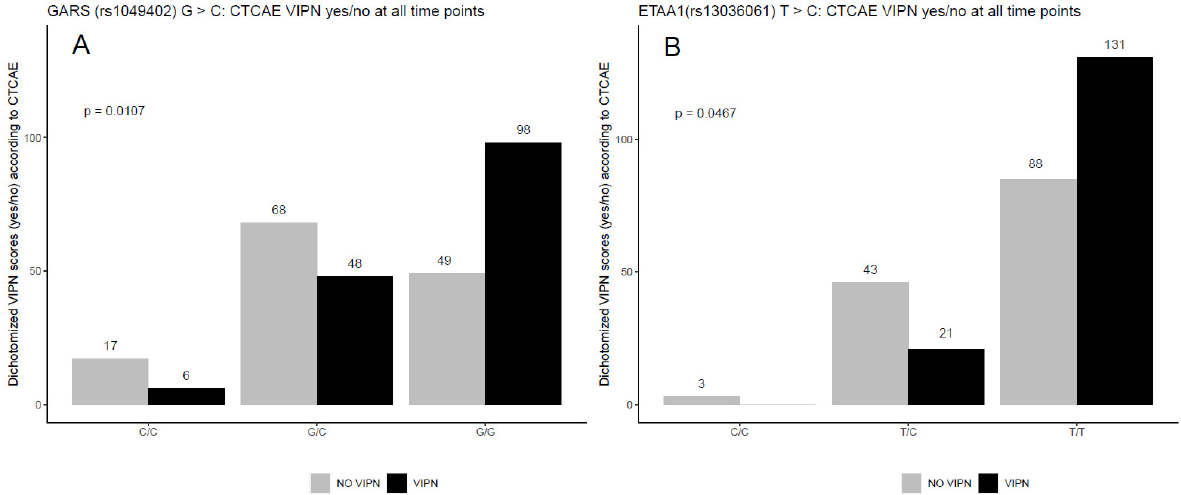
Figure 2. ( A ): Association between a SNP in NRDG1 and total Common Toxicity Criteria of Adverse Events (CTCAE) score. ( B ): Association between a SNP in GARS and total CTCAE score. ( C ): Association between a SNP in FGD4 and pediatric-modified Total Neuropathy Score (ped-mTNS). ( D ): Association between a SNP in CEP72 and ped-mTNS score. VIPN measurements were performed 1–5 times in 85 patients. Every VIPN measurement per patient across the time points is shown. The number in the boxplot indicates the number of observations per genotype. The p -value was derived from Poisson regression analysis for repeated measures, where the genotype was considered to be a categorical variable. NRDG1: N-Myc Downstream Regulated 1, GARS: Glycyl tRNA Synthetase, FGD4: FYVE, RhoGEF and PH Domain Containing 4, CEP72: Centrosomal Protein 72.